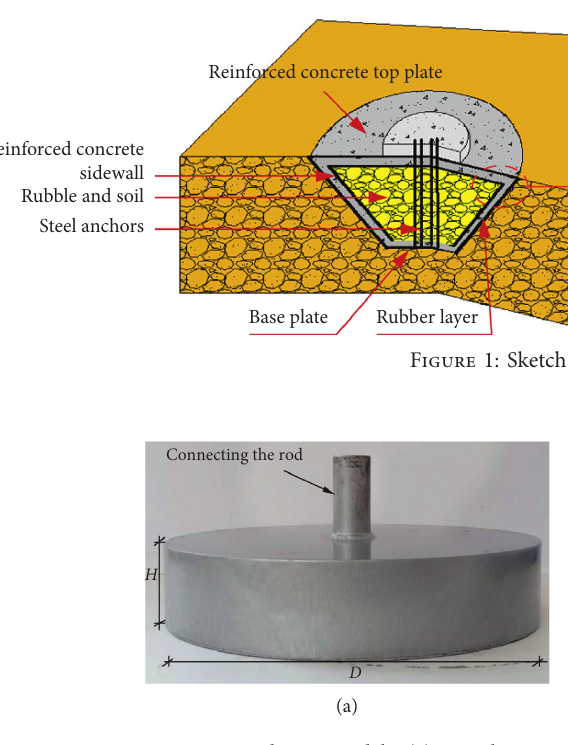
Figure 2: Foundation models. (a) Circular gravity-based foundation model. (b) CHFRF model. Table 1: Dimensions of the foundation models.